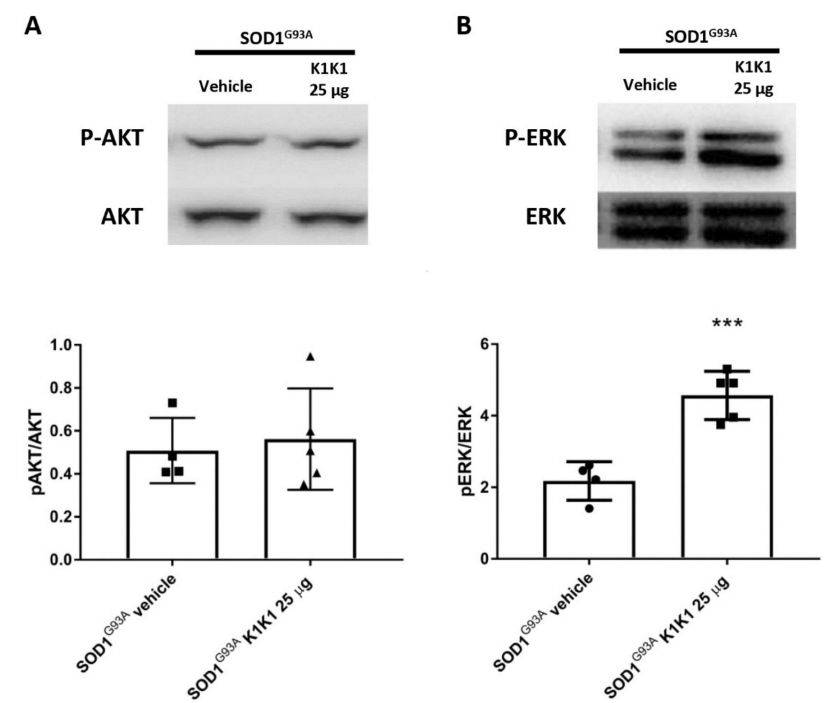
Figure 3. Treatment with 25 µ g K1K1 increased only extracellular signal-related kinase (ERK) phosphorylation in lumbar spinal cord of SOD1G93A mice. ( A , B ) Representative immunoblots of p- Protein kinase B (AKT) / AKT and phospho-extracellular signal-related kinase (p-ERK) / ERK and relative quantification performed on the ventral portion of lumbar spinal cord of transgenic SOD1G93A mice treated with vehicle or 25 µ g K1K1. ( A ) Chronic treatment with K1K1 does not change p-AKT / AKT levels while increases the p-ERK / ERK activation in 140 days old SOD1G93A mice with respect to vehicle treated mice. Bars represent mean ± SEM ( n = 4 − 5). All data were statistically analyzed using Student’s t -test *** = p <